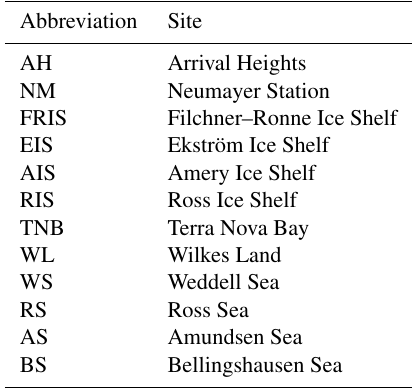
Table 1. List of abbreviations for the geographical names shown in Fig.